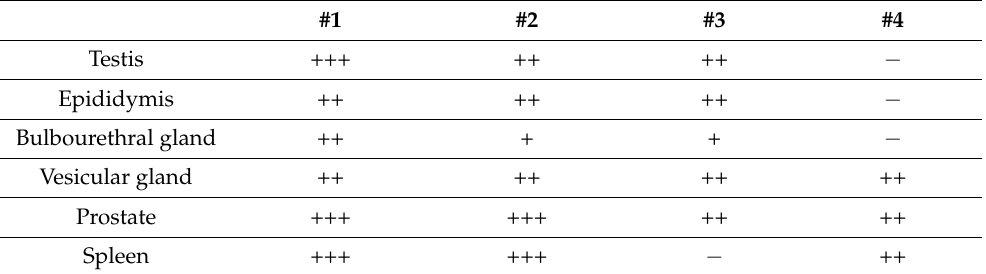
Table 3. Hemadsorption test results for reproductive organs of boars. #1